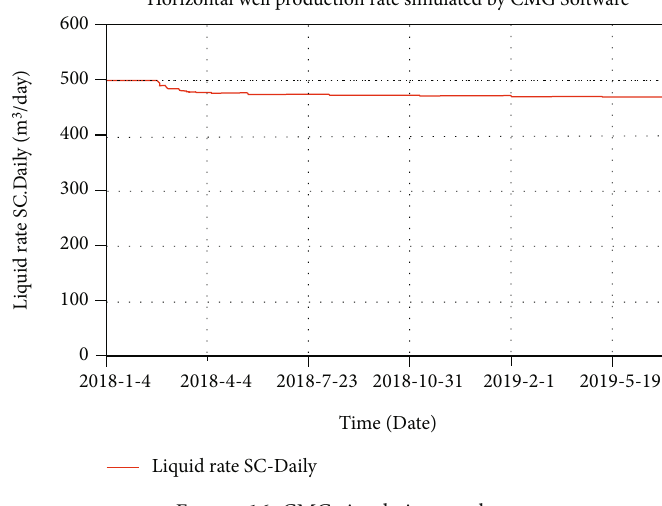
Figure 16: CMG simulation